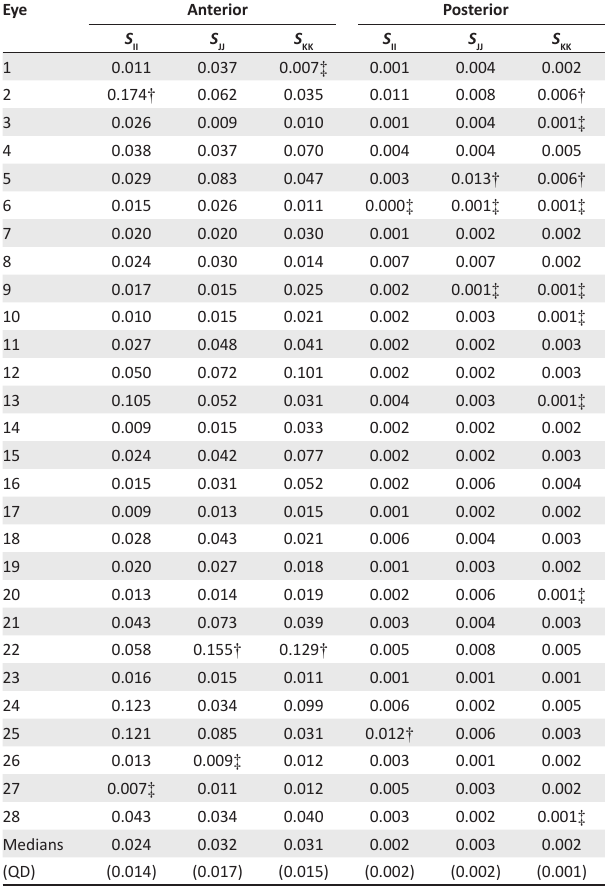
TABLE 4: Variances (D 2 ) extracted from the variance-covariance matrices for anterior and posterior central corneal power for 28 eyes with KC where S S are the stigmatic and two antistigmatic variances; they relate to variances KK along the stigmatic and antistigmatic axes of stereo-pair scatter plots (such as in Figure 1), respectively. Maxima and minima for each column are indicated in red and blue, respectively. Medians and quartile deviations are also